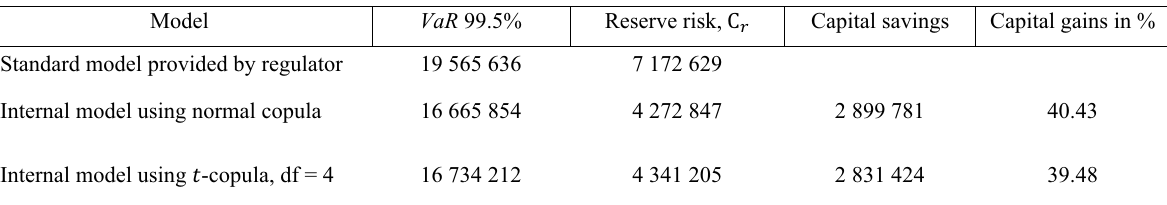
Table 3. Goodness of fit, numerical results of hypothesis